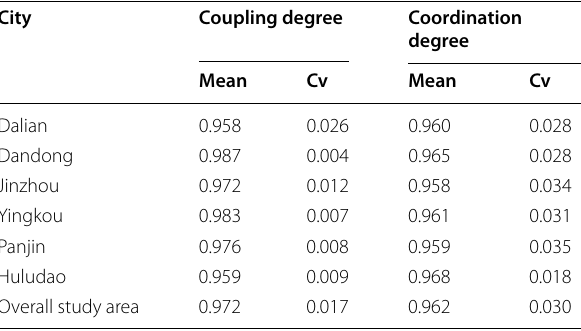
Table 2 Inter-city differences in spatiotemporal coupling degree and coordination degree of comprehensive evaluation of the marine governance efficiency of the six coastal cities in Liaoning from 2004 to 2019